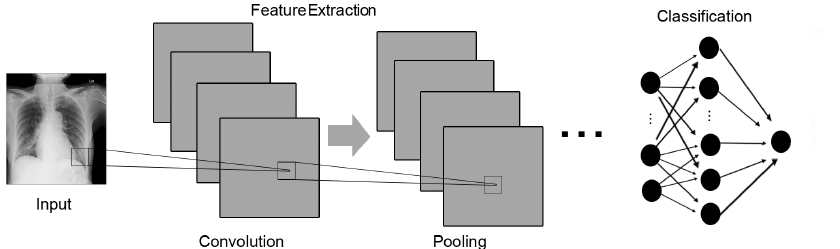
Figure 4. Convolutional neural network (CNN) architecture. Source: prepared by the authors and inspired by